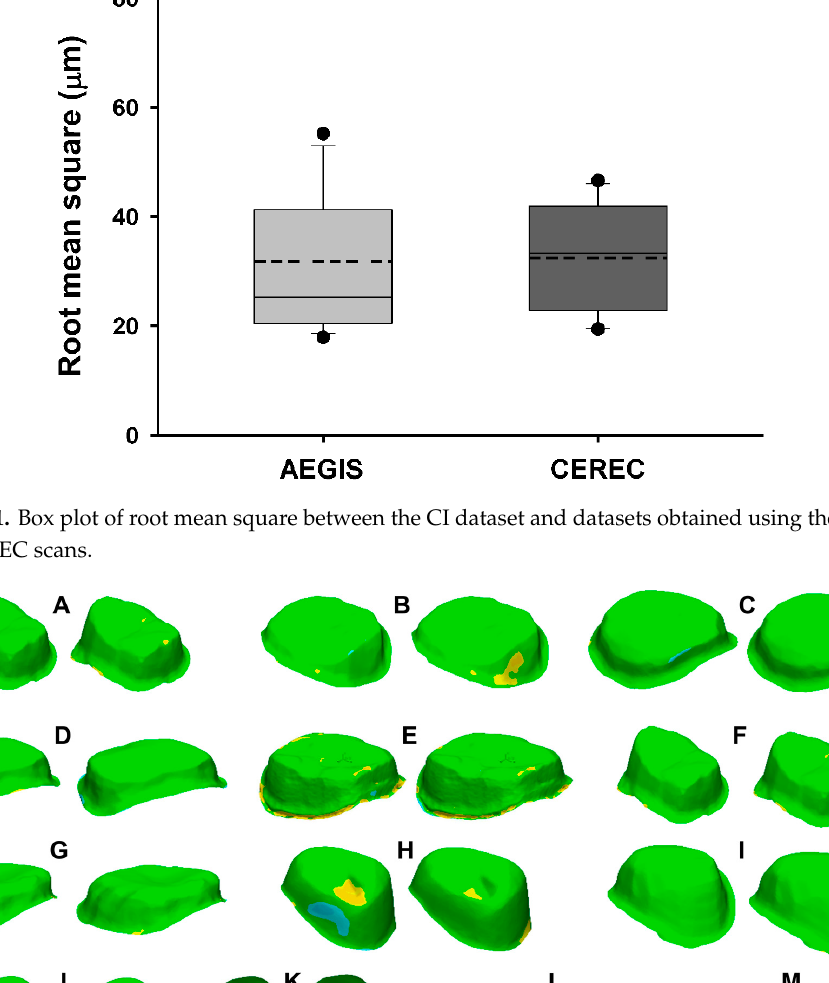
Figure 10. Box plot of the mean positive and negative deviations after superimposition of the CI dataset with datasets obtained from the AEGIS and CEREC scans.